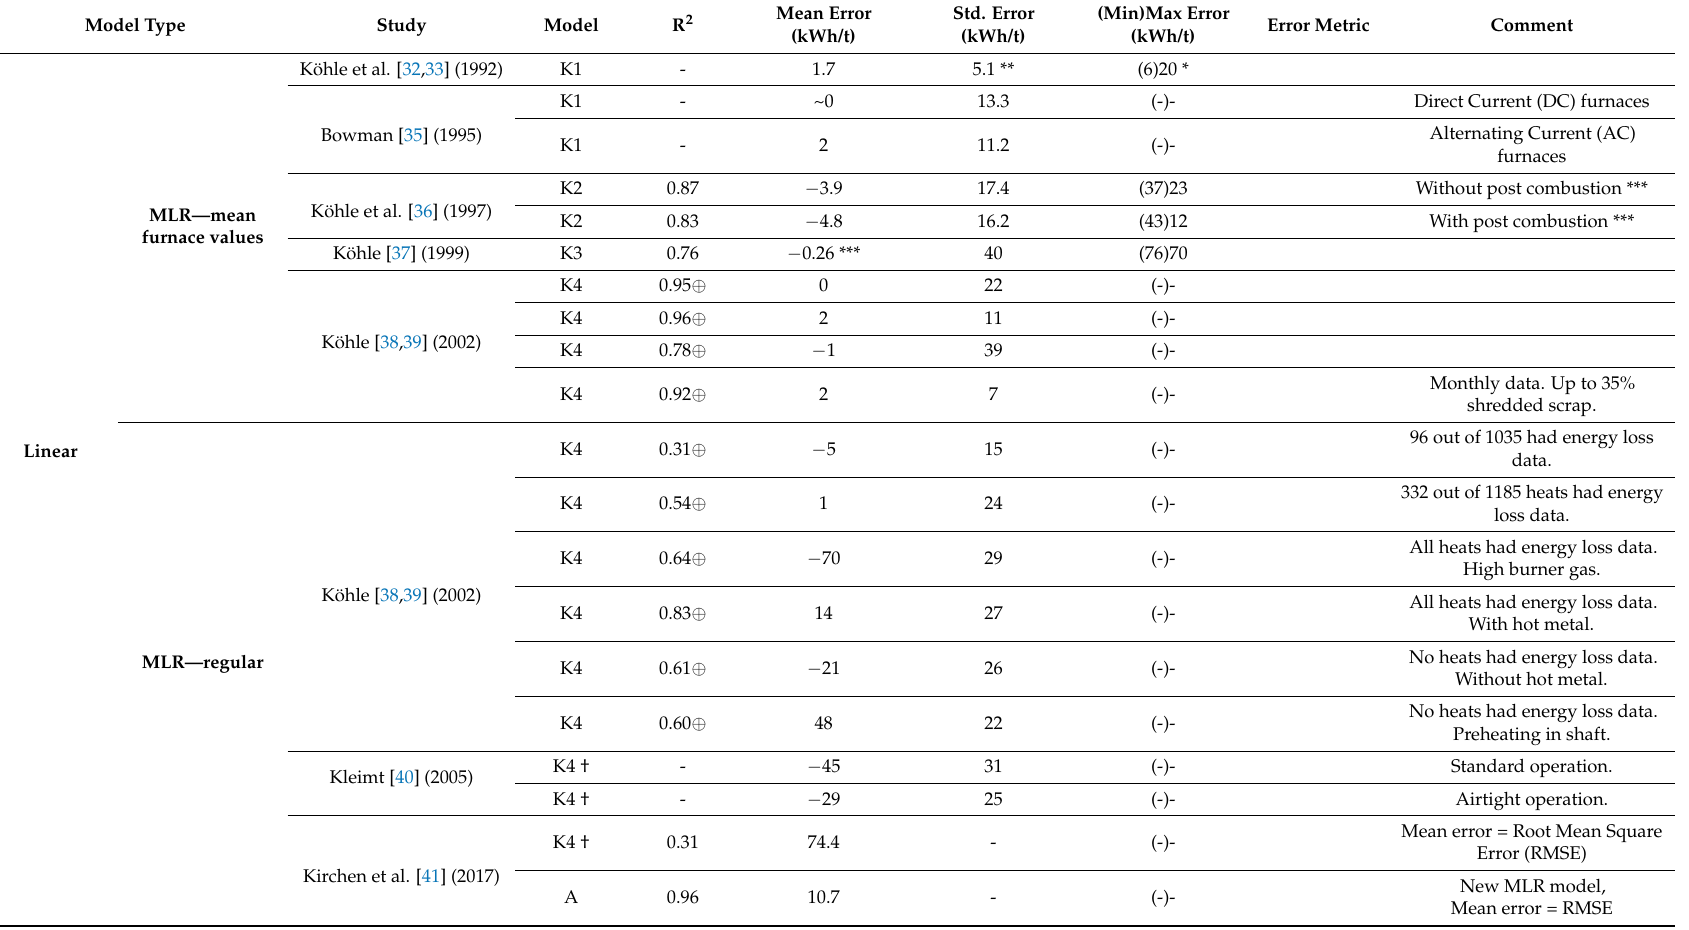
Table 6. Model performance. Each entry represents a new model or heats tested on another model. Blank entries on the “Error metric” column means that information was not provided for the model. Specifications are marked and explained further below. * From visual inspection from a graph. ** Not taking into consideration the outlier that has 20 kWh/t error. *** Value(s) calculated from table in the reference. ++ Mean Absolute Error and Absolute Error were used. † Evaluated on future single heats, single heats from another furnace, or applying own single heats on another model. ⊕ Correlation coefficient instead of R 2